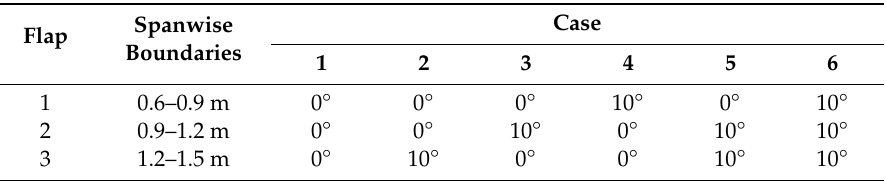
Table 1. Case definition for different flap combinations.